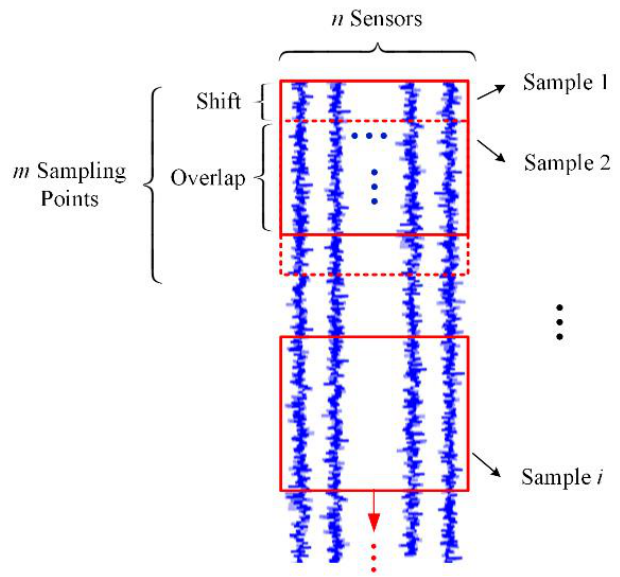
Figure 5. Overlapping sampling process.